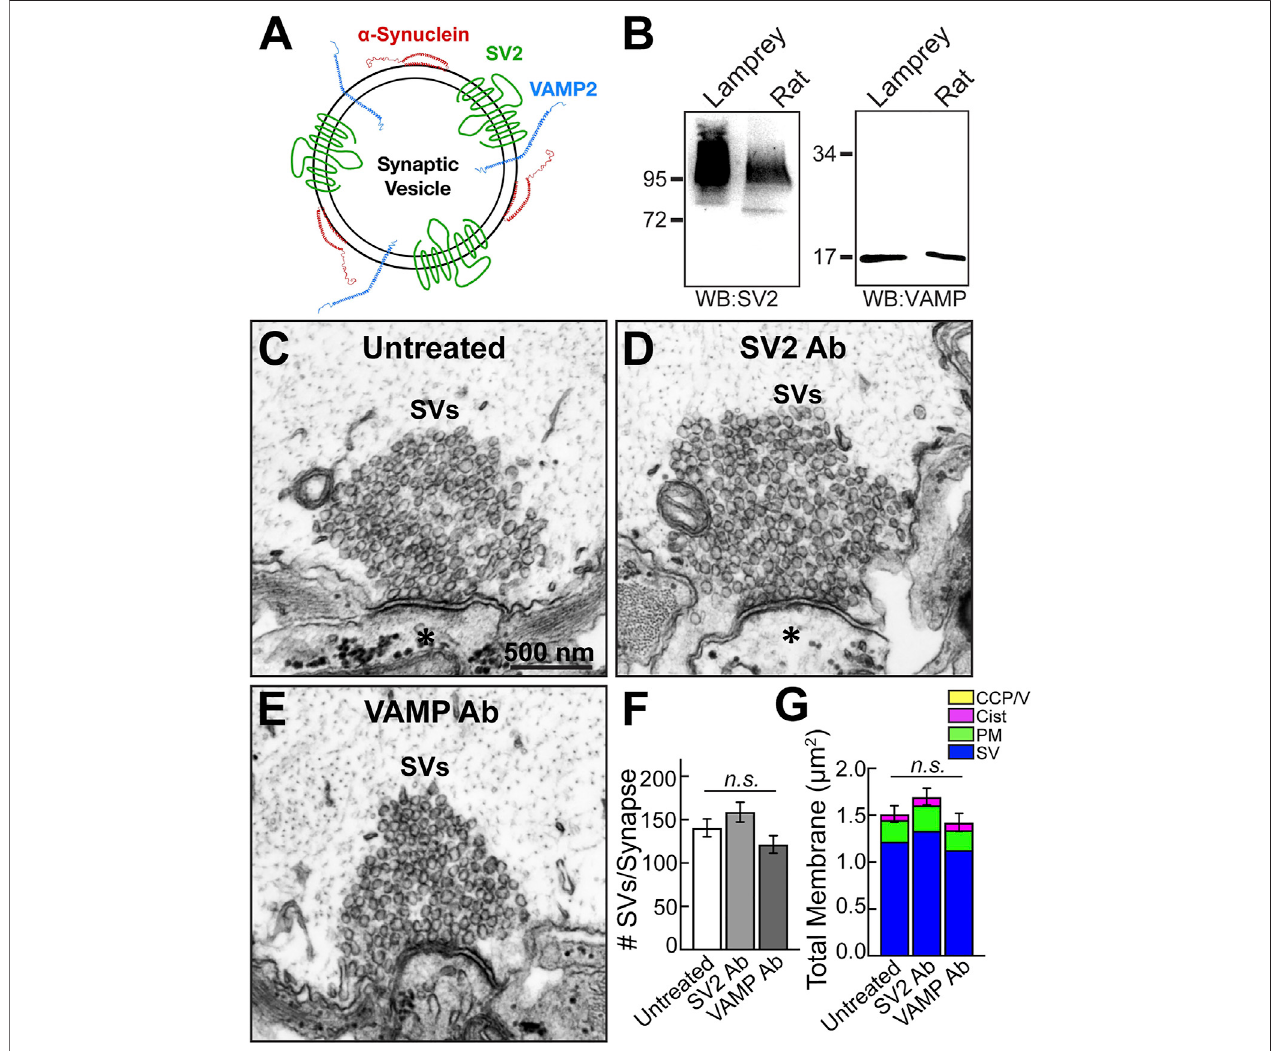
FIGURE3| MicroinjectionofSV2andVAMPantibodieshadnonoticeableeffectonsynapticvesicleclusters. (A) Diagramofasynapticvesicleshowing α -synuclein and two other vesicle-associated proteins, SV2 and VAMP. (B) Western blots against SV2 and VAMP show bands of the expected molecular weights in both lamprey CNSandratbrainproteinlysates.TheSV2bandappearsasasmearduetoextensiveglycosylationoftheprotein. (C – E) Comparedtountreated synapses,noapparent changes in the morphologies of synaptic vesicle clusters were observed after treatment with either the SV2 or VAMP antibody. Asterisks mark the postsynaptic dendrites. Scale bar in C is 500 nm and applies to D-E. (F) SV2 and VAMP antibodies did not signi fi cantly impact the number of synaptic vesicles at synapses. Data are plotted as mean/section/synapse. (G) No changes were observed in the membrane distributions after treatment with the SV2 or VAMP antibody. Bars in F and G represent mean ± SEM from n (cid:2) 24 – 38 synapses, 2-4 axons/animals. n. s. indicates “ not signi fi cant ” by ANOVA.